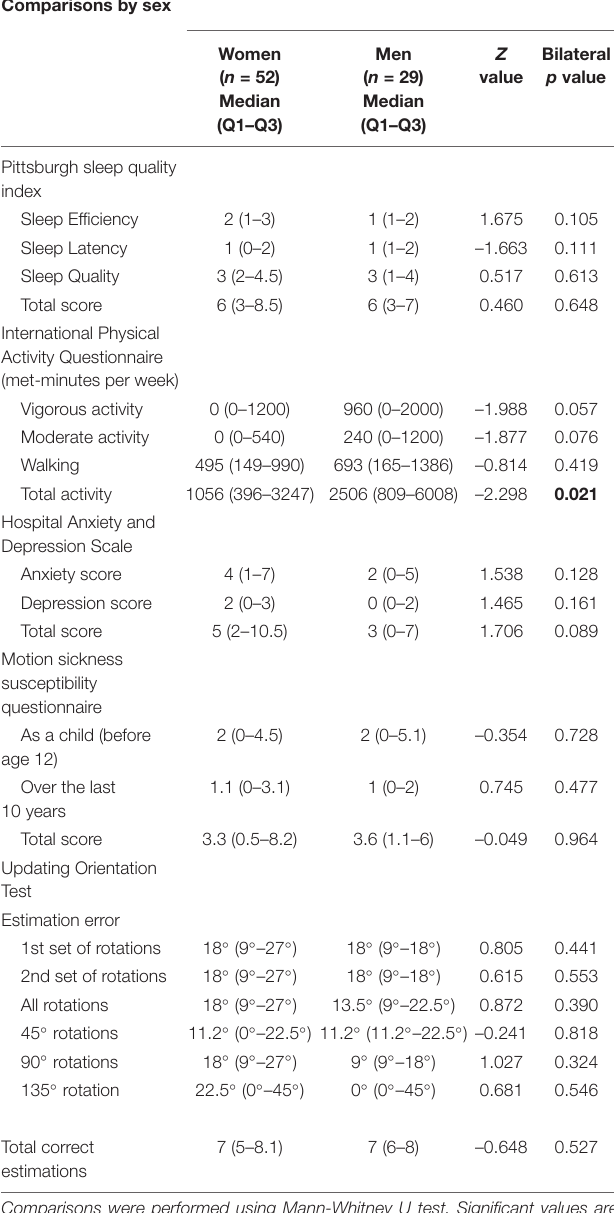
TABLE 3 | Median, Quartile 1 (Q1) and Quartile 3 (Q3) of the Pittsburgh sleep quality index, International Physical Activity Questionnaire, Hospital Anxiety and Depression Scale, Motion Sickness Susceptibility Questionnaire, and updating orientation results by